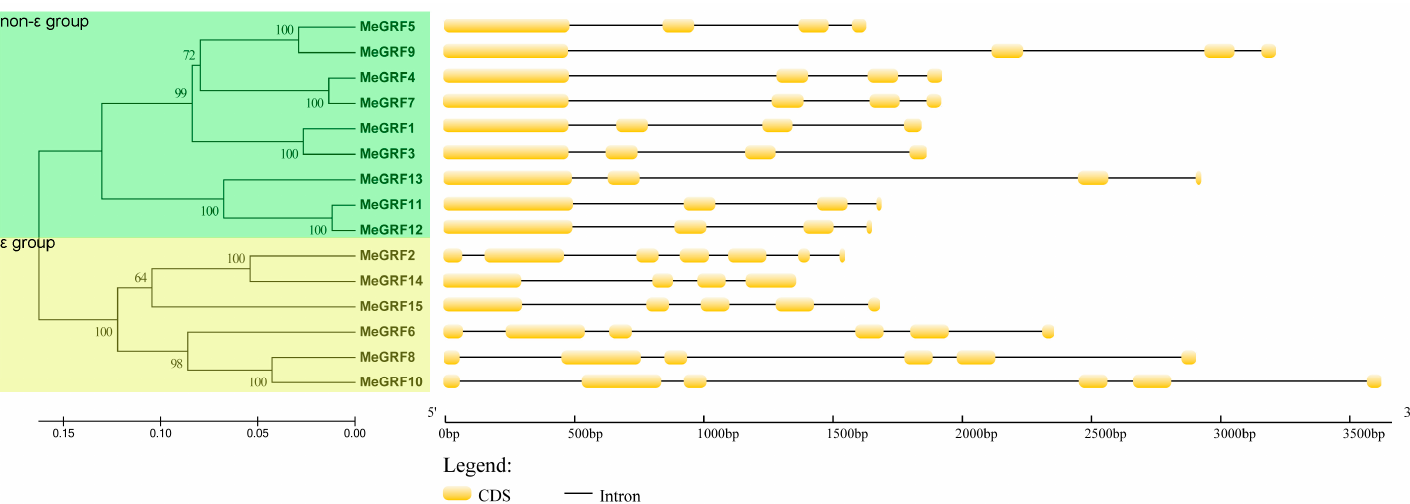
Figure 3. Exon-intron structure analyses of cassava GRFs. Gene structure display server (GSDS) database was used to analyze the exon-intron structures of MeGRFs. The yellow boxes represent exons and the black lines are introns [50].